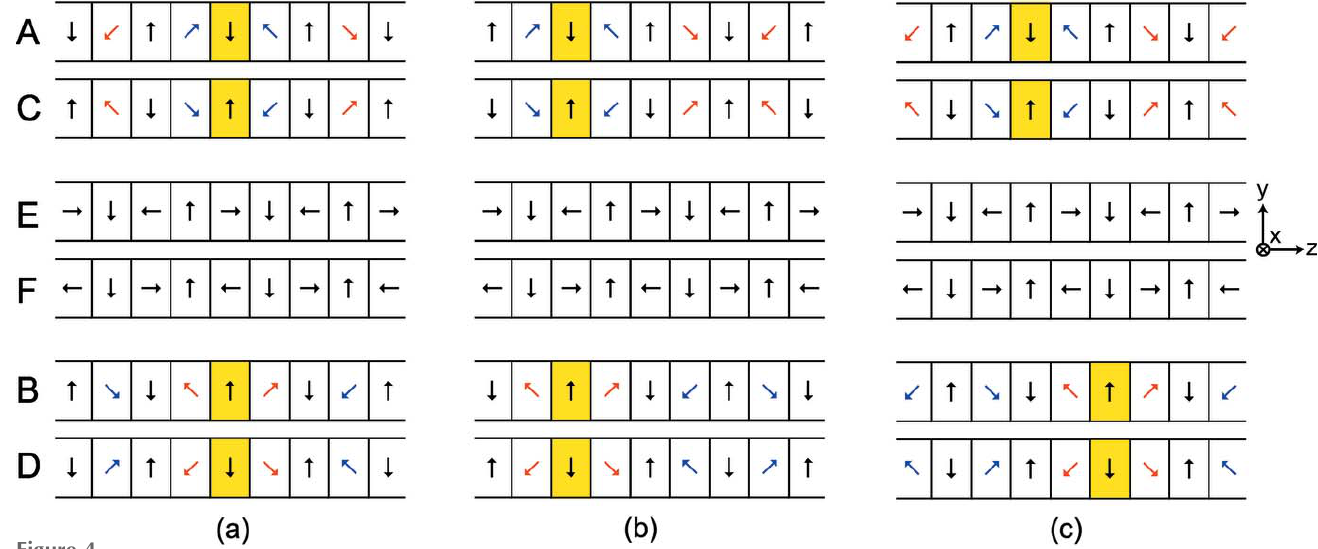
Figure 4 Operation modes of HEU120: ( a ) CW helical, ( b ) CCW helical and ( c ) figure-8 modes.